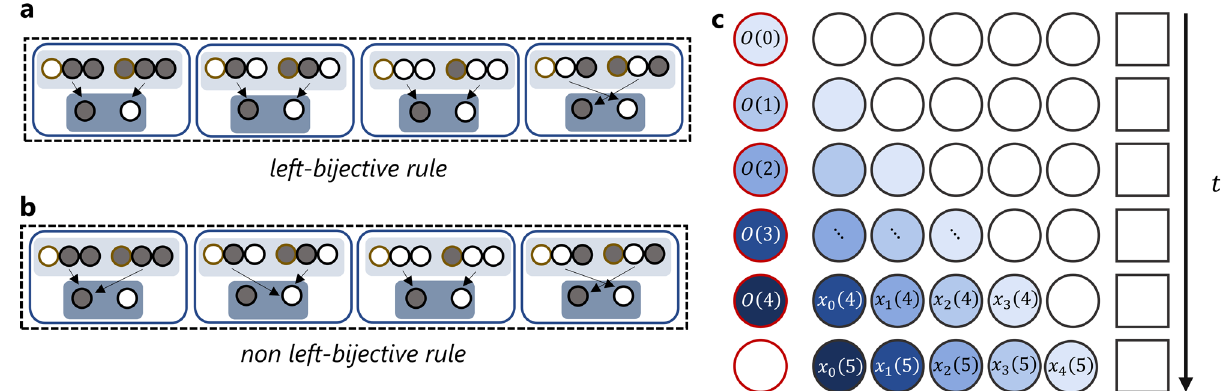
Fig. 4 Construction of the organizer sequence for a left-bijective update rule. a Illustration of a left-bijective rule (black box) for an elementary two-state cellular automaton. The eight possible input con fi gurations are grouped into four pairs (blue boxes) according to the states of the middle and right-hand cells (dark boundaries) of the rule inputs (light blue shading). For each of these pairs, the rule establishes a one-to-one mapping between the state of its left input cell (light boundary) and its output (dark blue background). Figure S6 illustrates the bijectivity of all programmable rules in a similar way. b In contrast, a rule that maps at least one pair of input states onto the same output state is not left-bijective ( fi rst and second pair in the shown example). c Illustration of the construction scheme for the organizer sequence O ð t Þ that steers an initial pattern to a desired target pattern. In this example, the system has L ¼ 5 bulk cells and an organizer cell on the left (red boundary). The construction scheme determines the organizer sequence by backward propagation from the target pattern, and explicitly demonstrates that bijectivity implies programmability. All white cells are not in fl uenced by the organizer sequence O ð t Þ , so their states can be computed from the initial pattern with the update rule. Back propagation then begins by setting the value of the rightmost cell in the fi nal pattern to the desired value x 4 ð 5 Þ . Since x 4 ð 4 Þ and x 5 ð 4 Þ are known, left-bijectivity guarantees that there is a value x 3 ð 4 Þ such that x 4 ð 5 Þ has the desired value. Similarly, it is possible to set x 2 ð 3 Þ such that x 3 ð 4 Þ takes on the required value determined in the previous step. Iterating along the diagonal with the lightest blue shade then fi xes the fi rst organizer input, O ð 0 Þ . Back propagation of x 3 ð 5 Þ (second lightest blue shade) then fi xes O ð 1 Þ and so forth (each back propagation indicated by a different blue shade). Thus, bijectivity of the update rule suf fi ces to construct an organizer sequence O ð t Þ to steer a given initial pattern into any desired target points in state space occupied by the ensemble at time t . As the patterning process proceeds from every possible initial state along every possible shortest path to the target state S ð t Þ , decreases from L to zero. The computed time traces S ( t ) for a system of size L ¼ 8 with the different programmable rules are shown in Fig. 3i (circular topology) and Fig. 3j (linear topology with organizer cells at both ends). In the latter case, S ð t Þ decreases roughly linearly for all rules, corresponding to an exponentially shrinking volume of the pattern ensemble in state space. The velocity of this ‘ entropy reduction ’ is either Δ S ¼ (cid:2) 1 or (cid:2) 2 (dashed and solid Δ t line, respectively). In the circular topology, S ð t Þ either decreases linearly with slope − 1, or displays a slower decrease with variable slope. Taken together, the dynamics of S ð t Þ is consistent with the spectrum of behaviors observed in the examples of Fig. 3a – h. It is also consistent with the behavior of the average shortest path length in the patterning graph (Supplementary Notes S3).